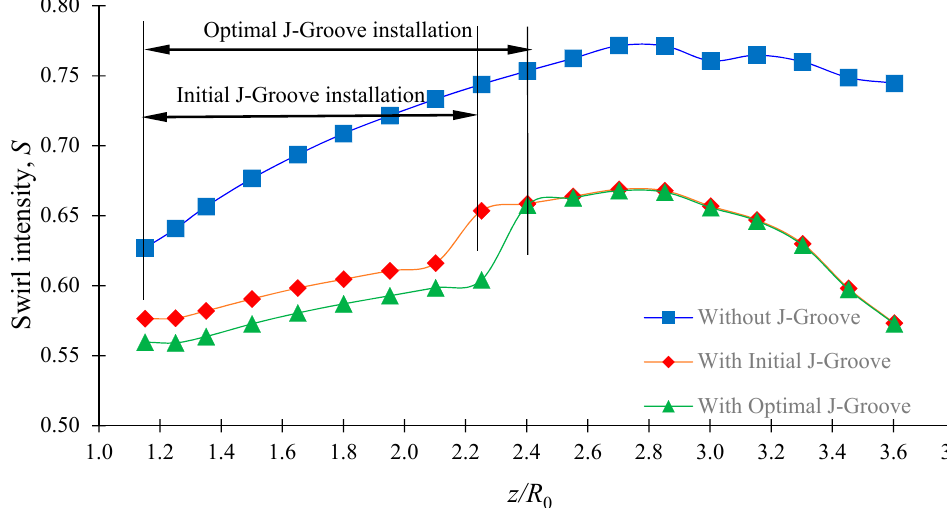
Figure 21. Comparison of swirl intensity in the draft tube by J-Groove shapes at the design point. Table 12. Summary of draft tube shape optimization results for the 100 MW class Francis turbine.